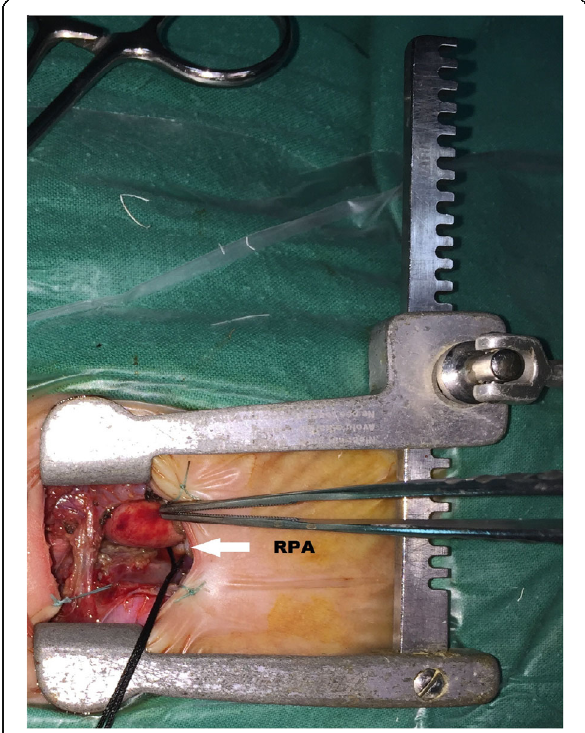
Fig. 1 Operative view showing the right pulmonary artery via the ministernotomy approach. RPA right pulmonary artery